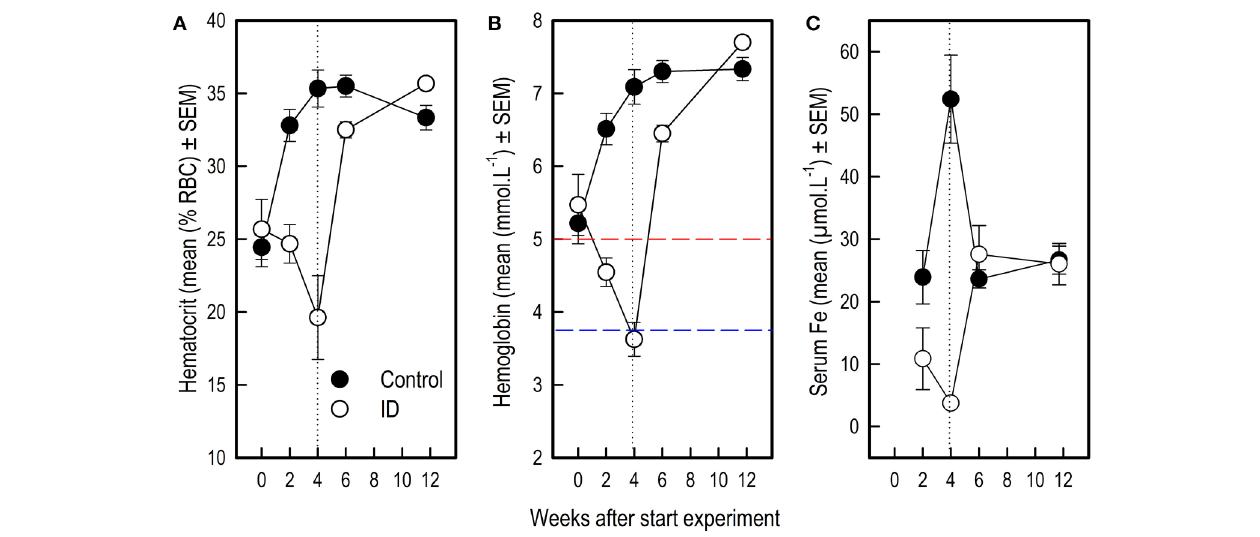
FIGURE 5 | Blood values in ID and control animals from 0 to 12 weeks after the start of the experiment. Dietary ID treatment lasted for 4 weeks (dotted black line). (A) Hematocritvalues(%redbloodcells); (B) Hemoglobinvalues.Thedashedredlineindicatesahemoglobinvalueof5,belowwhichpigletsareconsideredanemic, the dashed blue line indicates a value of 3.75, below which piglets are considered severely anemic (Ishaya, 2012); (C) Serum iron values. See Supplementary Tables 3 , 4 for results of the statistical analyses. Note that the number of observations varied per measure and sampling time point, as reported in Supplementary Table 1 .